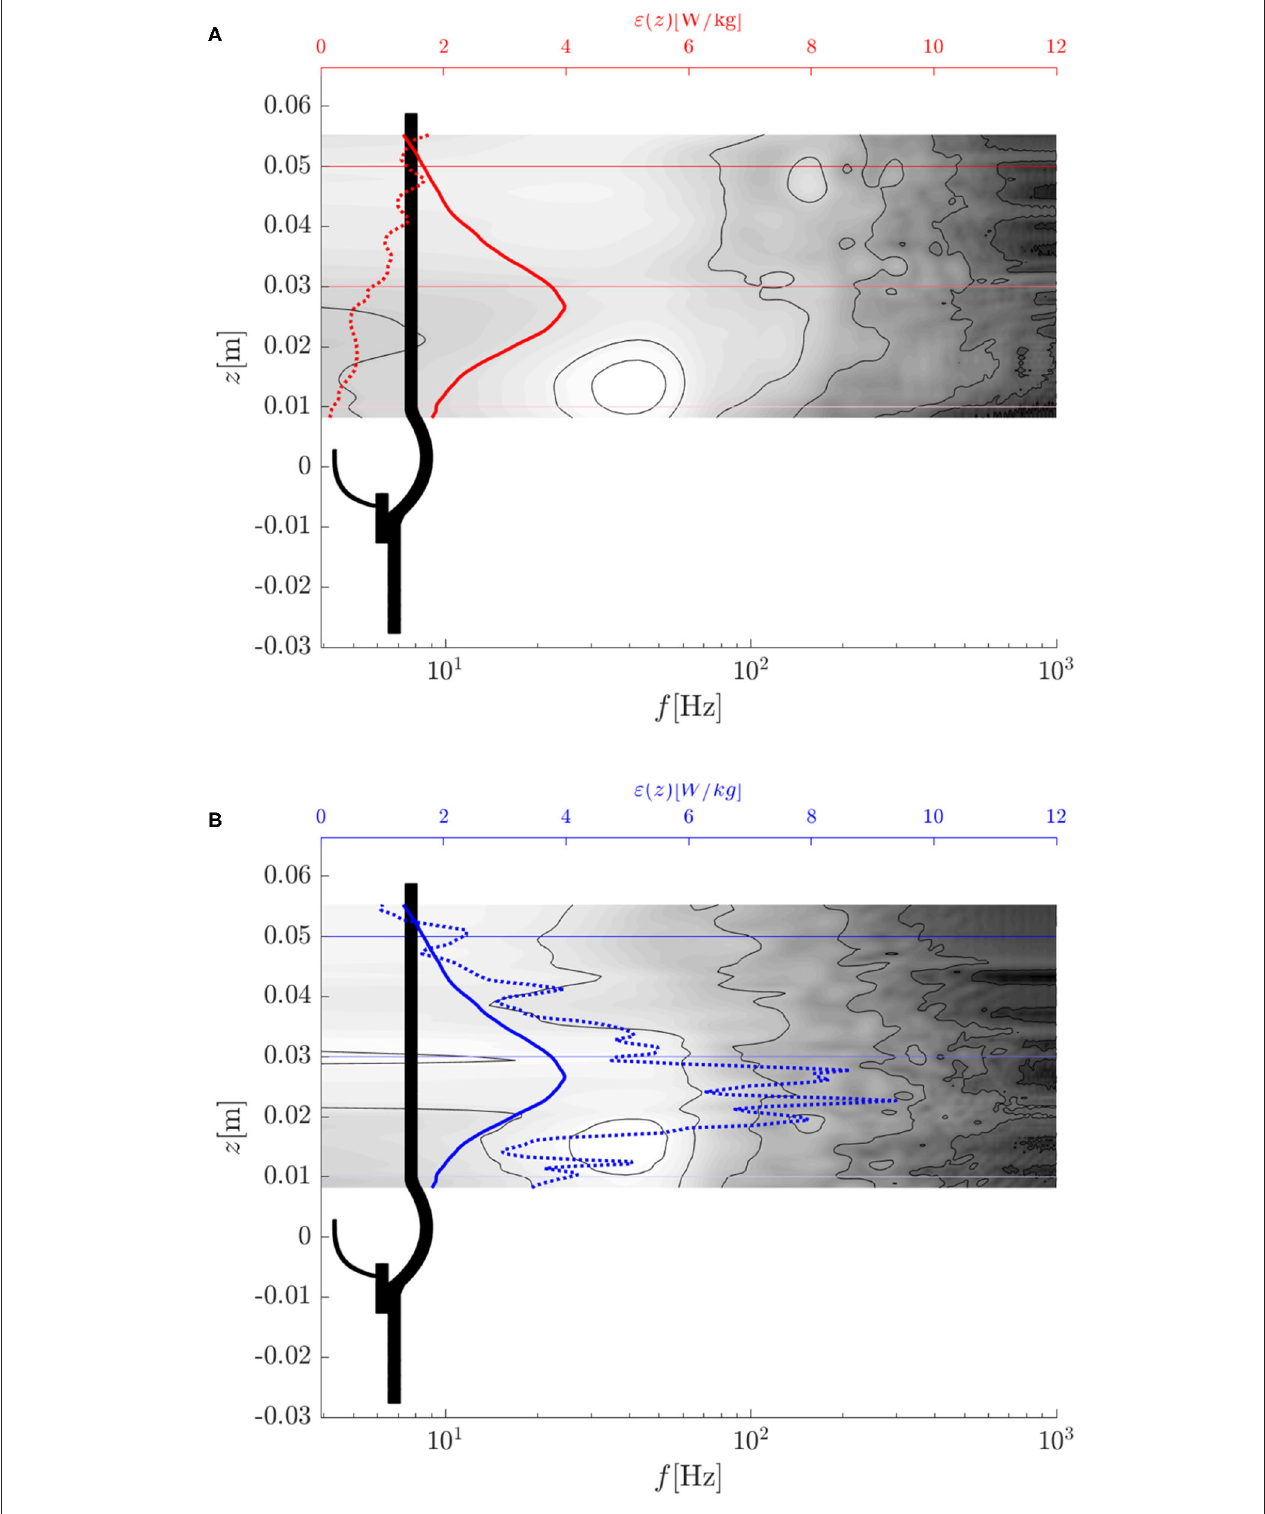
FIGURE 12 | Turbulent dissipation rate ǫ (dotted lines), average turbulent dissipation rate ǫ avg (solid lines) and temporal power spectral density of v ′ f , z ( x 0 , y 0 , z ) (contour plot: white indicates high values, dark for low values): (A) along the center line ( x 0 , y 0 , z ) = (0,0, z )m, (B) along a parallel line ( x 0 , y 0 , z ) = ( − 0.007,0, z )m.